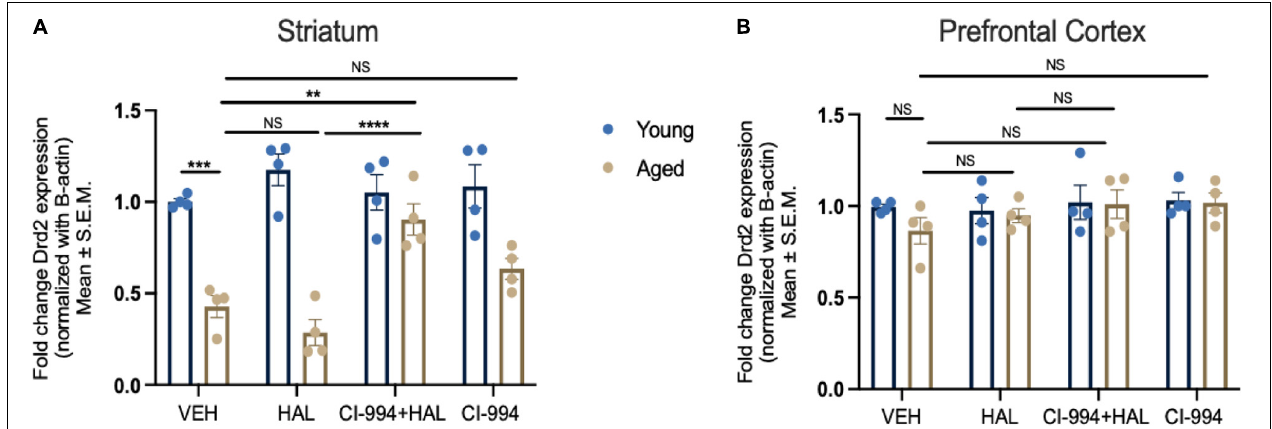
FIGURE 3 | CI-994 restores Drd2 gene expression in the striatum but not in the prefrontal cortex of aged mice. (A) Aged mice showed a significant decrease of Drd2 mRNA expression as compared to young mice (aged VEH vs. young VEH, p = 0.0007), however, HAL treatment did not impact Drd2 mRNA expression (aged VEH vs. aged HAL, p = 0.9050). CI-994 20 mg/kg with HAL significantly increased Drd2 expression (aged VEH vs. aged CI-994 + HAL 20 mg/kg, p = 0.0060; aged HAL vs. aged CI-994 + HAL 20 mg/kg, p < 0.0001). However, CI-994 20 mg/kg treatment alone did not have an effect on Drd2 mRNA expression (aged CI-994 20 mg/kg vs. aged VEH, p = 0.6034). (B) Chronic treatment of CI-994 at 20 mg/kg alone or combined with HAL did not increase Drd2 mRNA expression in the prefrontal cortex of aged mice. Data represent mean ± SEM ( n = 4/per group). ** p < 0.01, *** p < 0.001, **** p < 0.0001, NS, not